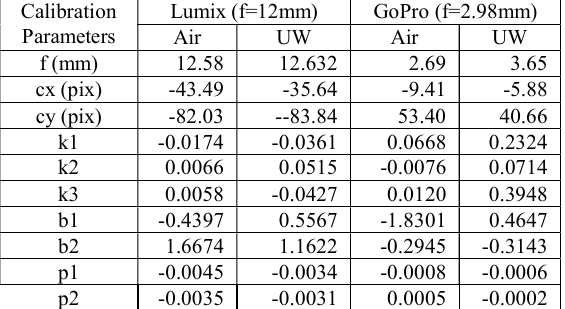
Table 2. Calibration results of camera systems in air and underwater. f is the focal length; cx and cy are the principal